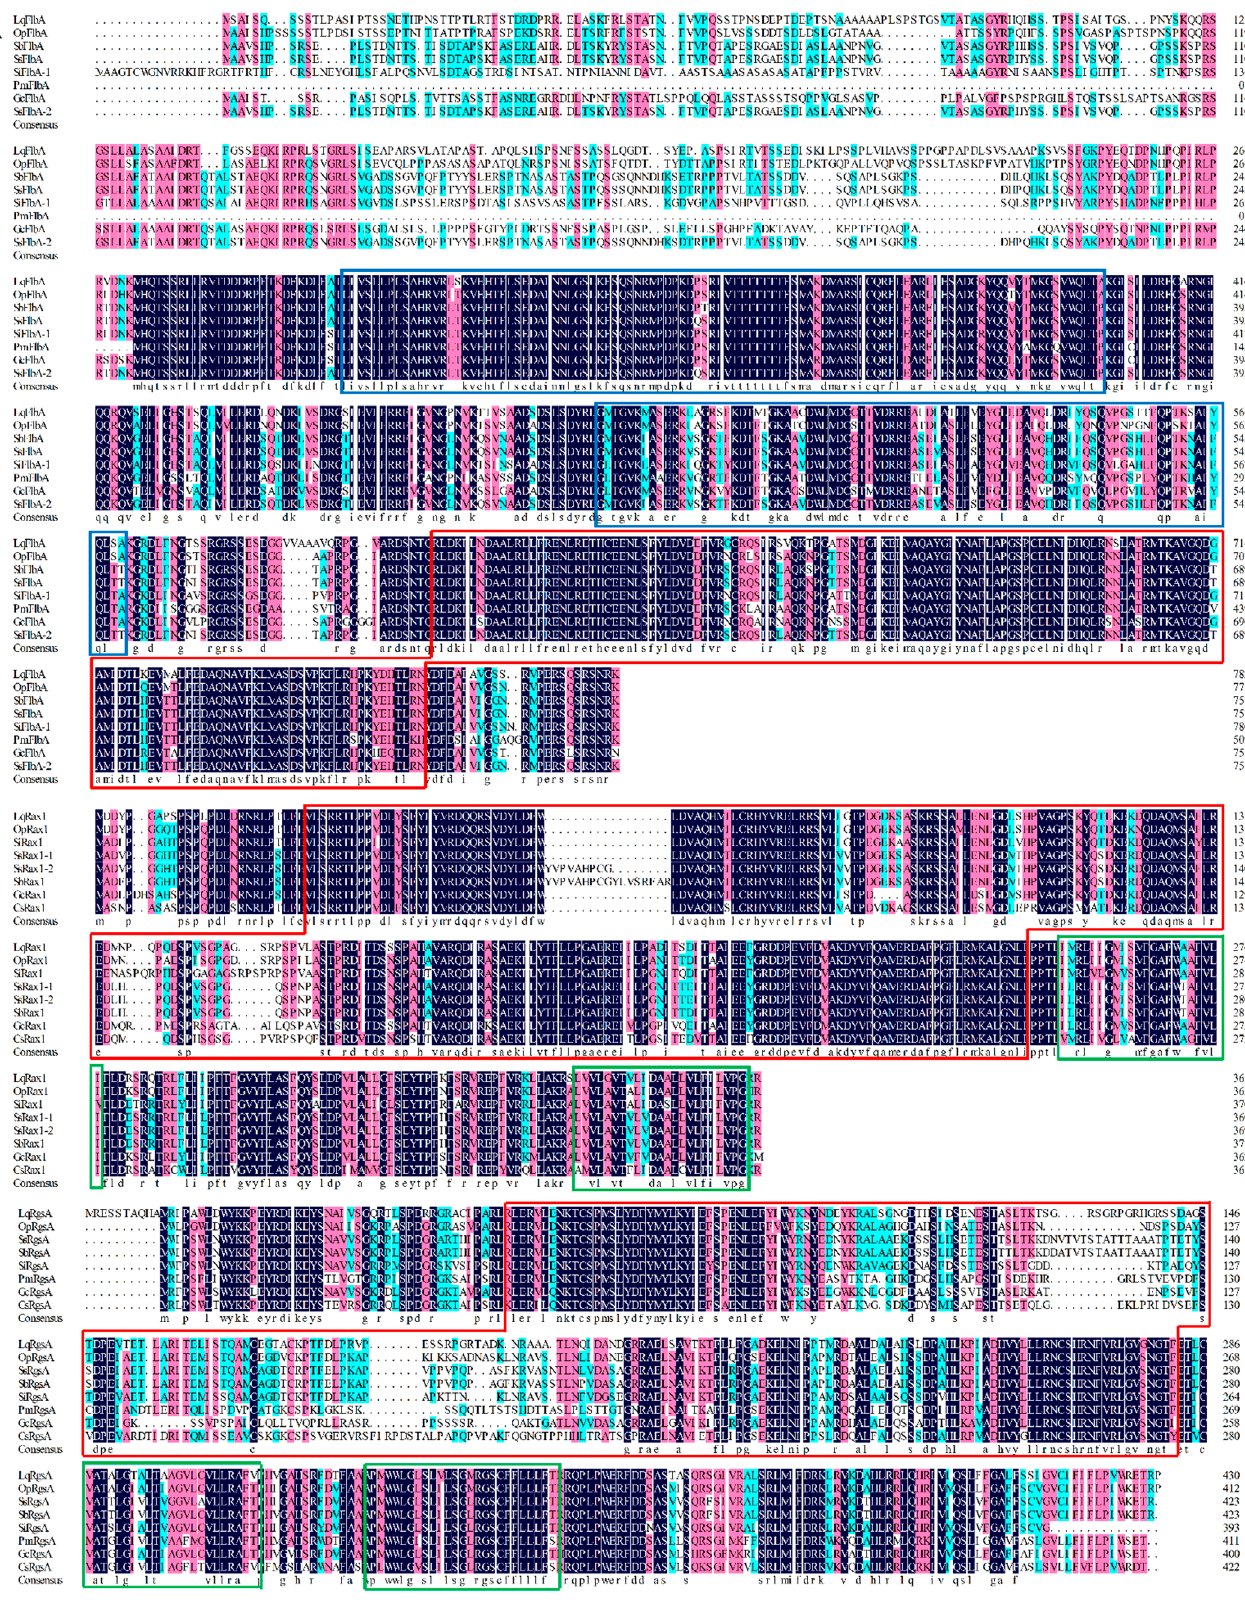
Figure 2. Structure of RGSs in L. qinlingensis . ( A ) Alignment of LqFlbA sequences and the consensus sequences in other species, including: O. piceae UAMH 11346 ( OpFlbA , EPE08676.1), S. brasiliensis 5100 ( SbFlbA , XP_040618117.1), S.schenckii ATCC58251( SsFlbA-1 ,ERS97713.1), S.schenckii 1099-18( SsFlbA-2